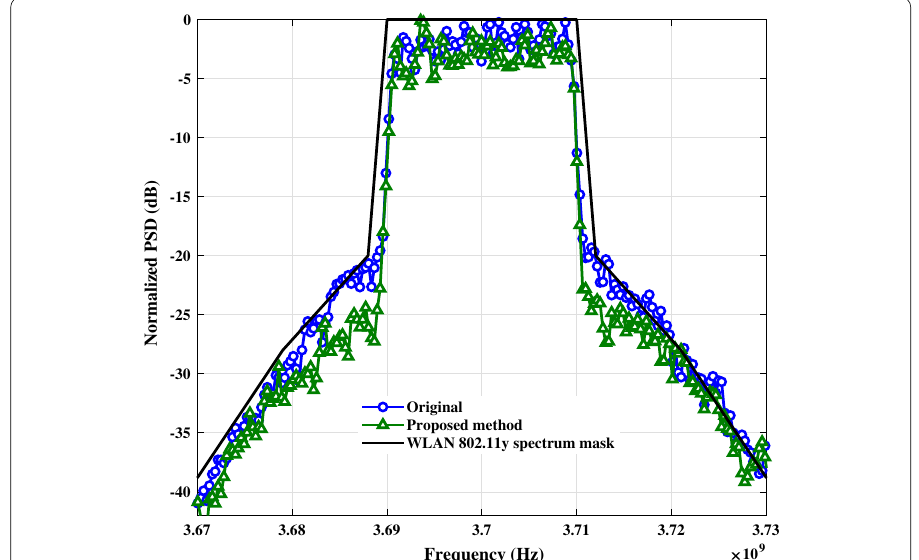
Performance effects